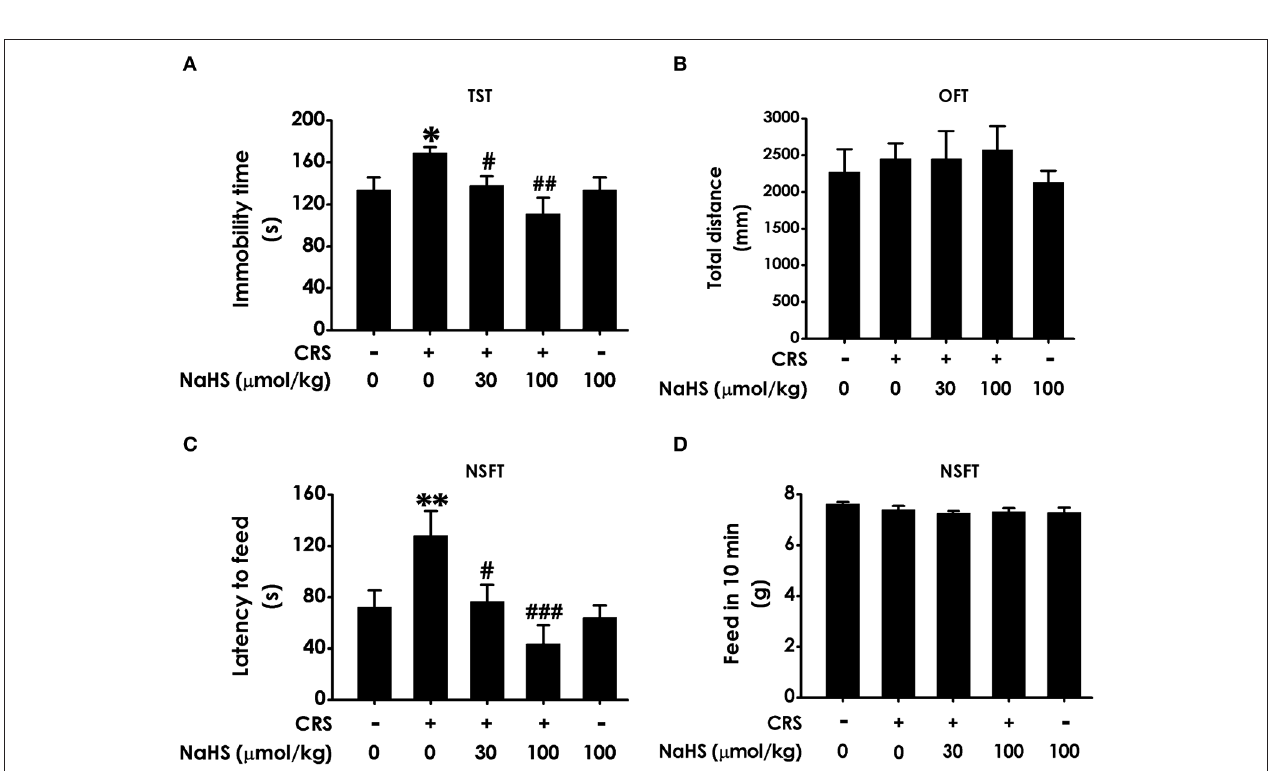
FIGURE 2 | Effect of H 2 S on the depressive-like behaviors in CRS-treated rats. SD rats were cotreated with CRS and NaHS (30, 100 µ mol/kg, i.p.) for 4w. Rats were underwent TST (A) , OFT (B) , and NSFT (C,D) to evaluate depressive-like behaviors. Values are expressed as the means ± SEM ( n = 6–10). * P < 0.05, ** P < 0.01, vs. control group; # P < 0.05, ## P < 0.01, ### P < 0.001, vs. CRS-treated alone